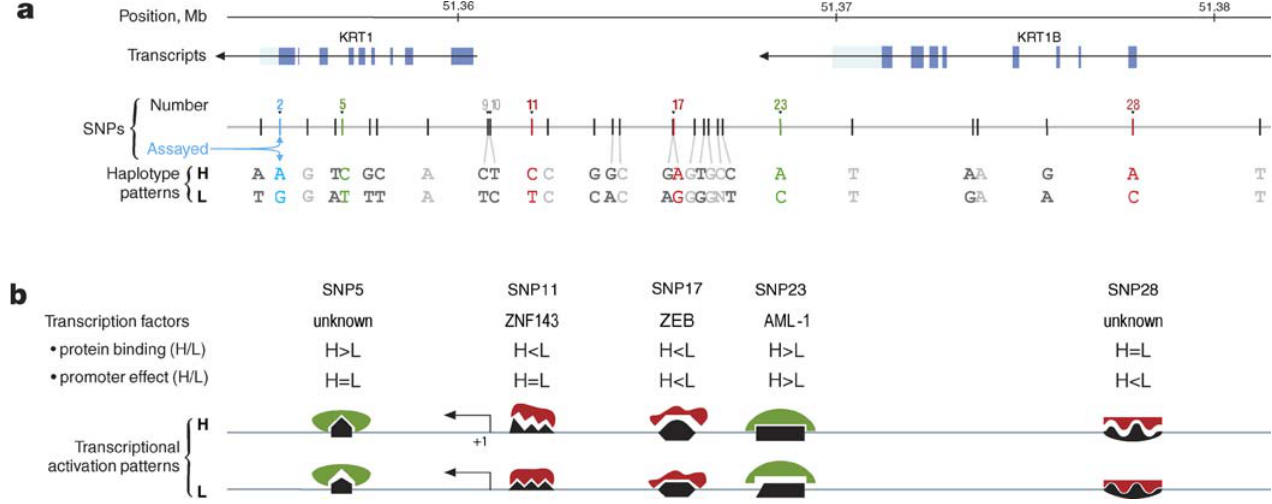
Figure 1. The KRT1 Haplotype Block (A) The locations of the KRT1 and KRT1B genes and each of the 29 SNPs (represented by a tick mark) are shown, with the SNPs discussed in detail numbered. The SNP alleles of the high- (H) and low- (L) expressing haplotypes are shown, with the 19 SNPs that differ between the two haplotypes highlighted. The exonic SNP (number 2) assayed for differential allelic expression is blue; those shown by transient expression assay to enhance or repress KRT1 promoter activity are green and red, respectively; and the rest are dark gray. (B) Results from the functional tests for five of the SNPs are summarized. The relative strength of protein binding by the low- and high-expressing SNP alleles is indicated by symbols ( . , , , or ¼ ). Similarly, the symbols ( . , , , or ¼ ) indicate the relative degree of increased or decreased KRT1 promoter activity of the low- and high-expressing SNP constructs. The diagram depicts that cis -regulatory SNPs 5 and 23 bind activators (green) as evidenced by increased KRT1 promoter activity over control constructs, and cis -regulatory SNPs 11, 17, and 28 bind repressors (red) as evidenced by decreased KRT1 promoter activity compared with control constructs. When differential binding or activity is observed, the activators have higher affinity to SNP alleles in the high-expressing haplotype (H), while the repressors have higher affinity to SNP alleles in the low-expressing haplotype (L). The names of proteins with consensus binding sites in the SNP-containing intervals are given. DOI: 10.1371/journal.pgen.0020093.g001